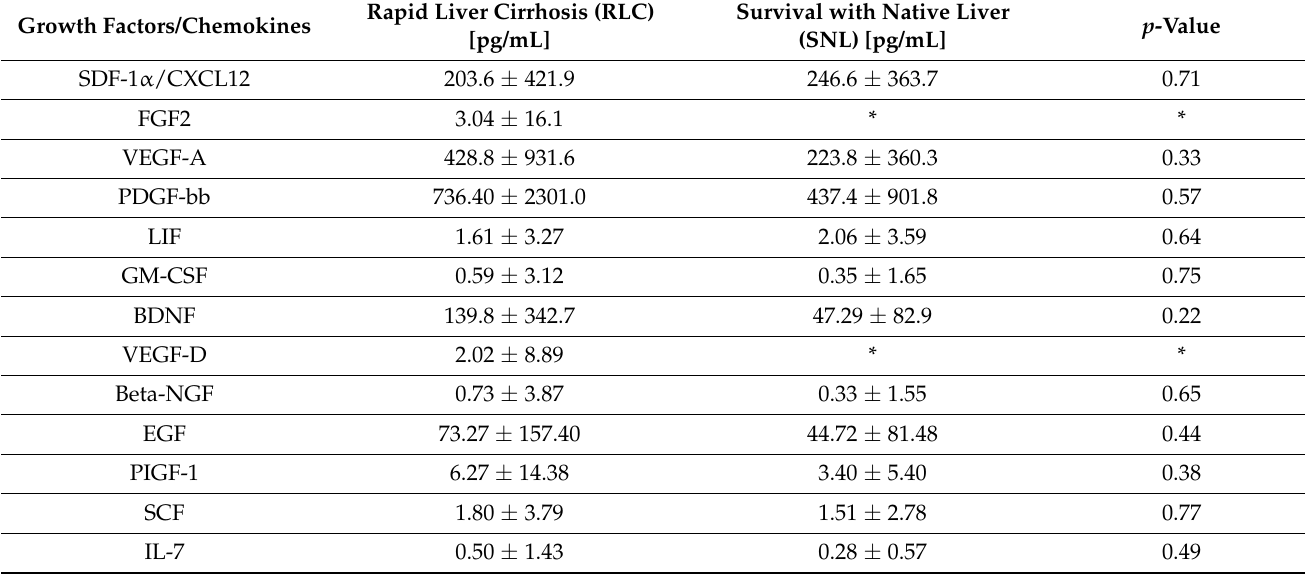
Table 4. Systemic growth factor profile.